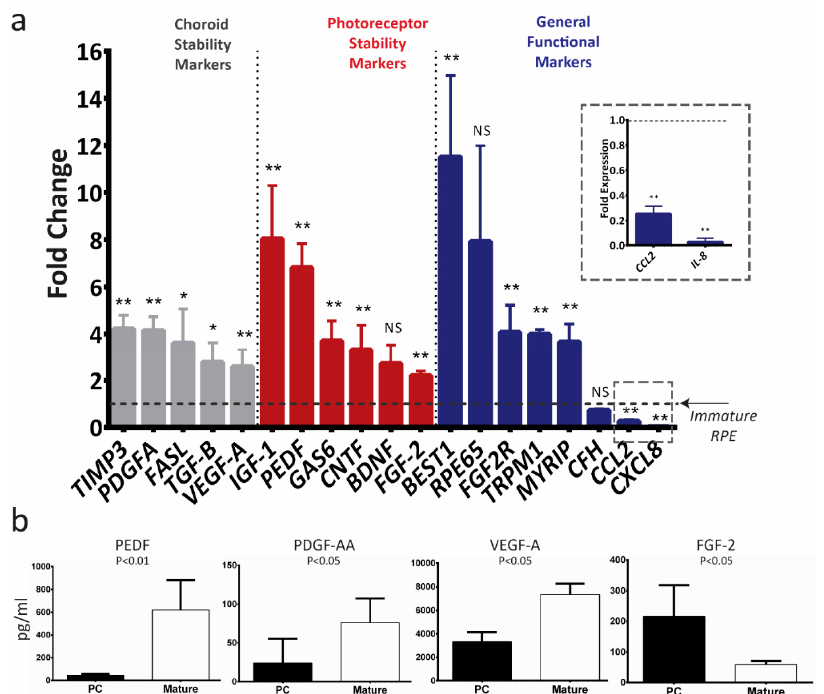
Figure 4. In vitro maturation of E-RPE cells upregulates the expression of therapeutically relevant photoreceptor and choroid trophic factors. ( a ) RT-qPCR analysis of mRNA levels of key RPE genes in mature E-RPE cells (>42 days in culture; n = 5). The results were normalized to an endogenous reference gene ( PPIA ) and are presented as mean fold change (2 −ΔΔ CT ) relative to immature E-RPE culture (dotted line) ± standard deviation. Data were compared with a Mann–Whitney U test of Δ Ct values; * p < 0.05; ** p < 0.01; NS: not significant. ( b ) Protein secreted by the post-confluent (PC) immature and mature E-RPE cultures into the conditioned media presented as mean concentration ± standard deviation (n = 5), Mann–Whitney U test. 2.5. Dissociation of the RPE Monolayer to Single Cell Suspension Resets Maturation We next investigated the effect of dissociation on RPE cells, as this is a common method of transplantation [24,25]. To do this, we matured E-RPE for 56 days before dissociation and passaging, followed by another 14 days of maturation. Interestingly, after passaging, a portion of E-RPE cells quickly regained the hexagonal morphology observed on day 56 but nearly all cells quickly lost pigmentation (Figure 5a). Even at two weeks postpassage, many (5/8, 62.5%) transcripts showed levels comparable with those from RPE four days after initial seeding (Figure 5b). We observed that mRNA levels of VEGF , IGF1 and FGF2 , which did not significantly increase during maturation, changed little after